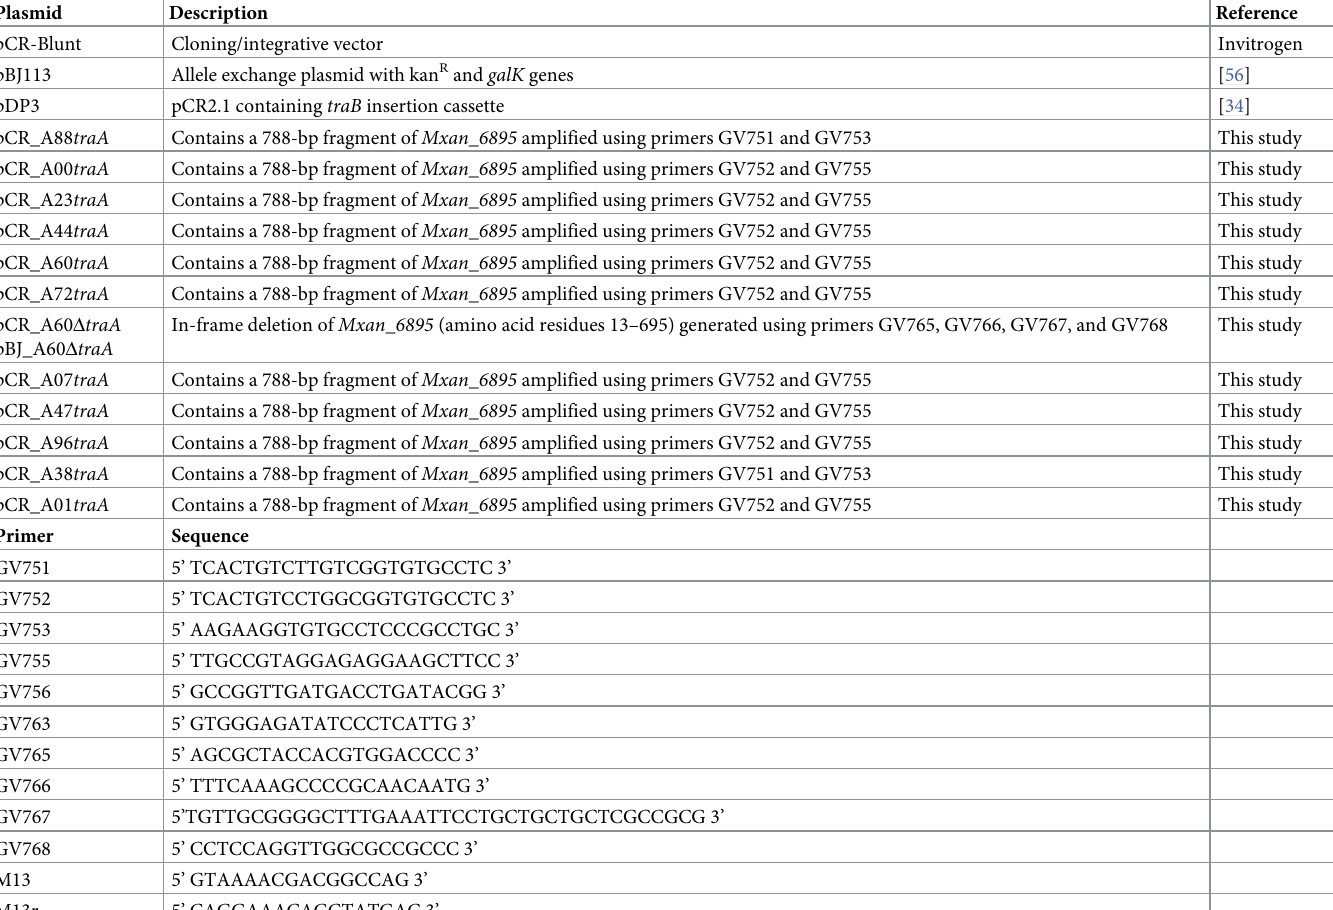
Table 2. Plasmids and